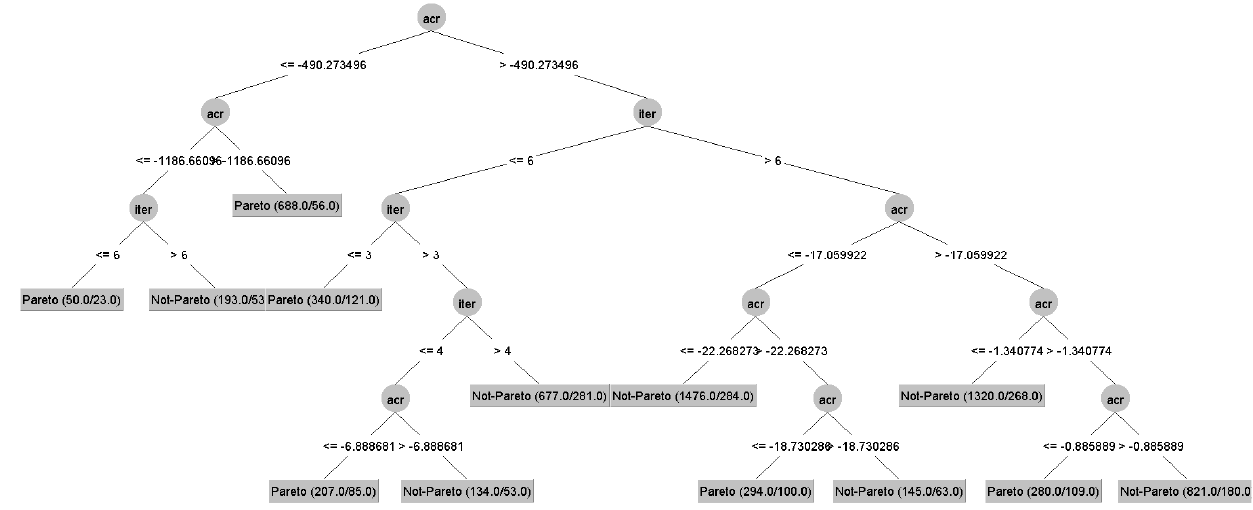
Figure 4. DT modeling of the choice between a Pareto and Not-Pareto decision depending on ACR and iteration.